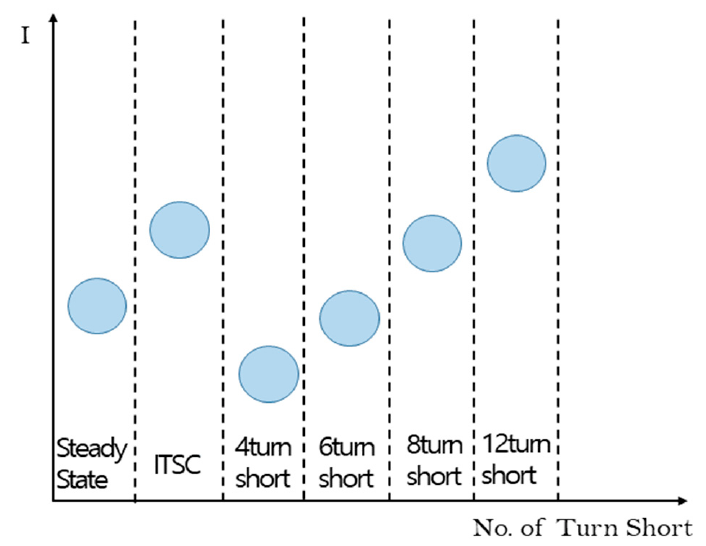
Figure 6. Magnitude change of I d current with increasing turn short circuits.